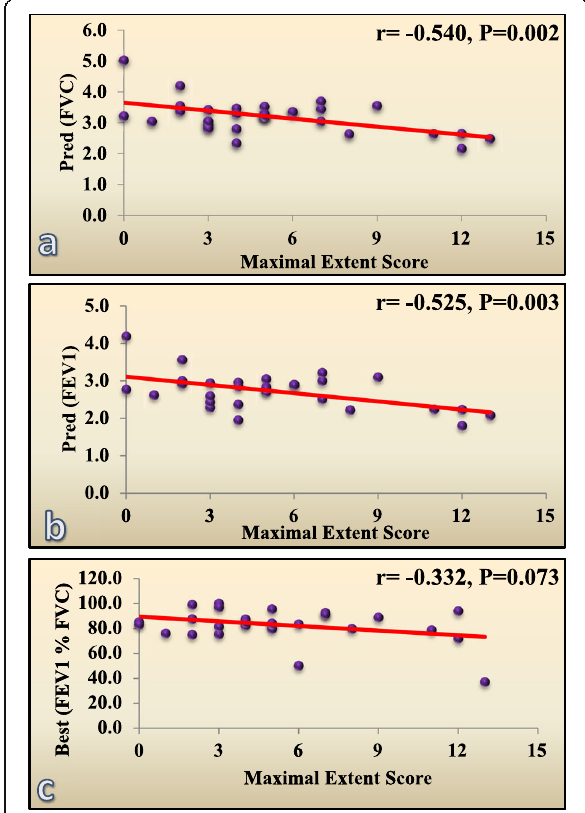
Fig. 9 a Correlation between maximal extent score and predicted (FVC). b Predicted (FEV1). c Best (FEV1%FVC)